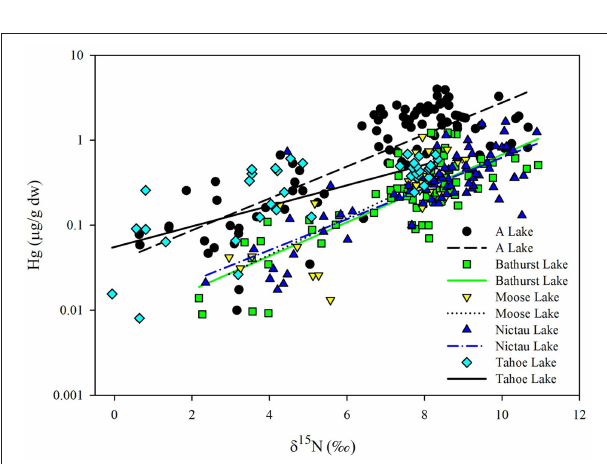
FIGURE 3 | Regressions of log Hg (THg in fish, MeHg in invertebrates; µ g/g dw) vs. unadjusted δ 15 N ( h ) for fish and invertebrates collected from A, Bathurst, Moose, Tahoe and Nictau lakes, New Brunswick. See Table 2 for regression